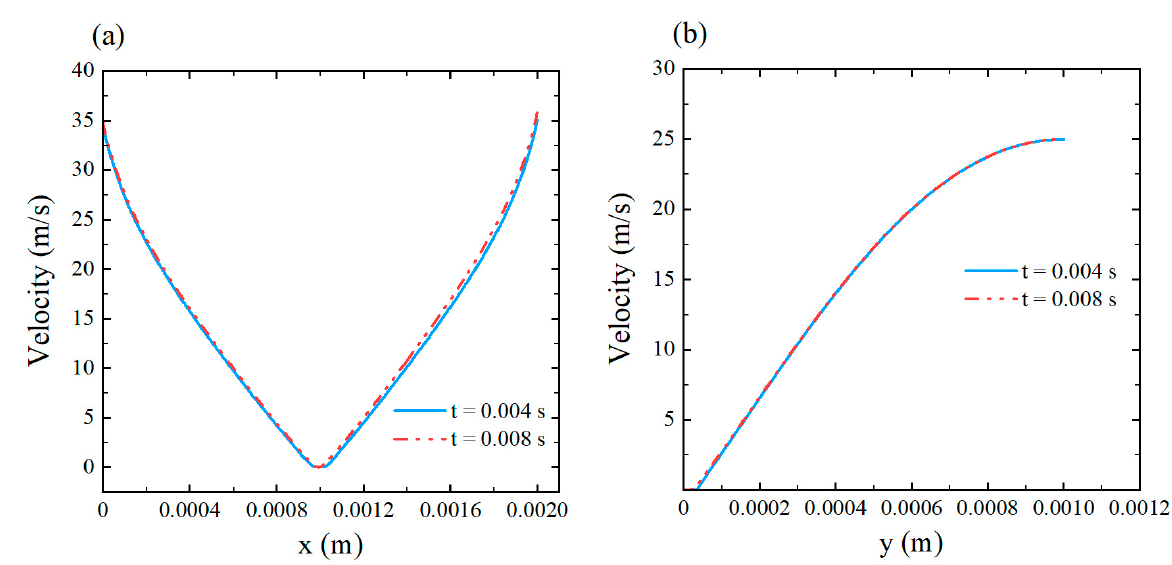
Figure 11. Distribution of velocity near the water-based ink droplet at y = 2 × 10 − 5 m ( a ) and x = 0.001 m ( b ).